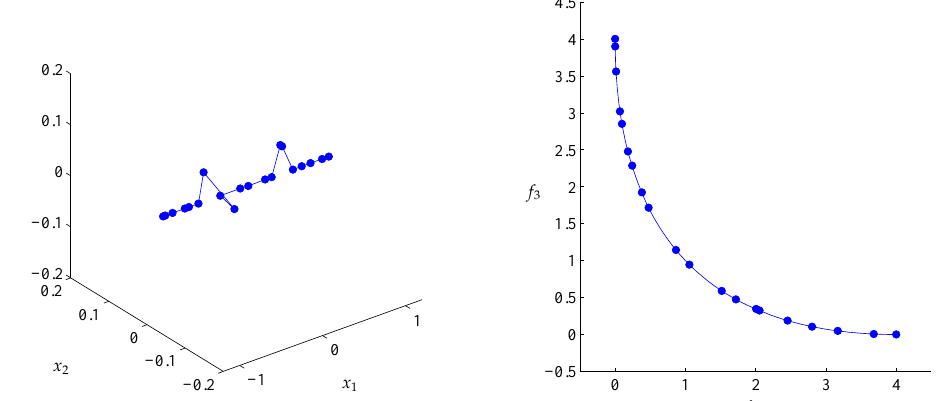
Figure 15. Left: Approximations A (blue dots) and B (blue continuous polygon line) of the Pareto set of MOP (14) in the 300th generation. Right: corresponding approximations F ( A ) and F ( B ) of the Pareto front.